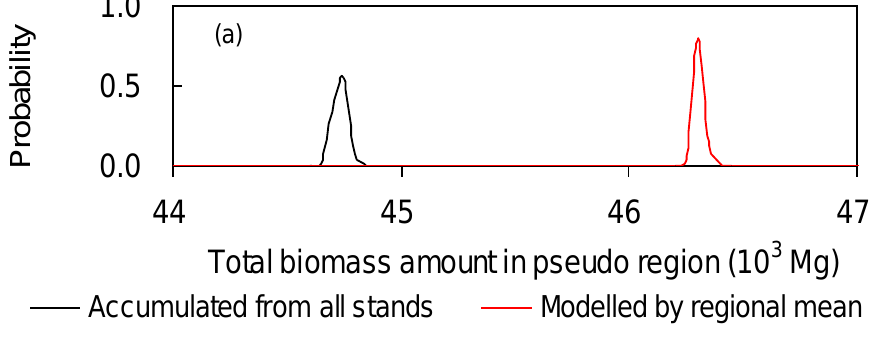
Table 2. A case study of biomass estimation for Pinus yunnanensis at the provincial scale. Forest Age Groups Unit